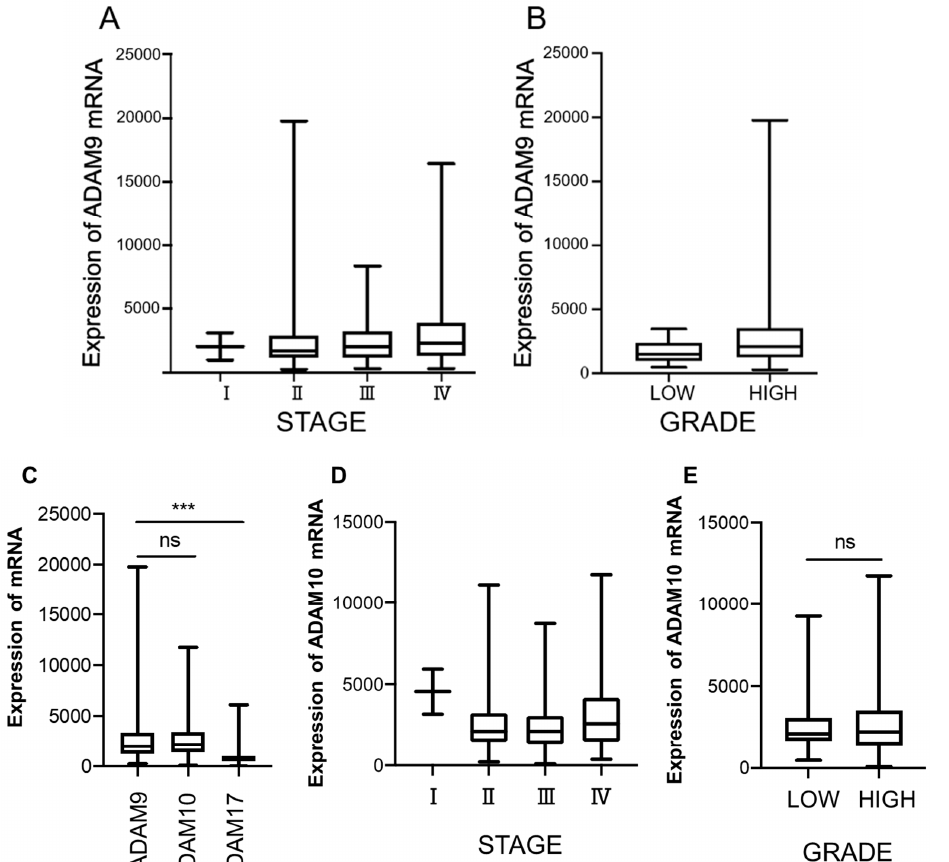
Figure 6. Expression of ADAM9 mRNA in bladder cancer patients: ( A ) the average level of expression of ADAM9 mRNA in stage IV bladder cancer patients was significantly higher than in other stages ( p < 0.05); ( B ) the expression of ADAM9 mRNA in high-grade bladder cancer was significantly higher than in low-grade cancer ( p < 0.05); ( C ) the comparison of ADAM9 with ADAM10 and ADAM17 mRNA expression in bladder cancer. The mRNA level of ADAM10 in ( D ) different stages and ( E ) histological grade (*** p < 0.0001, ns: no significant difference).